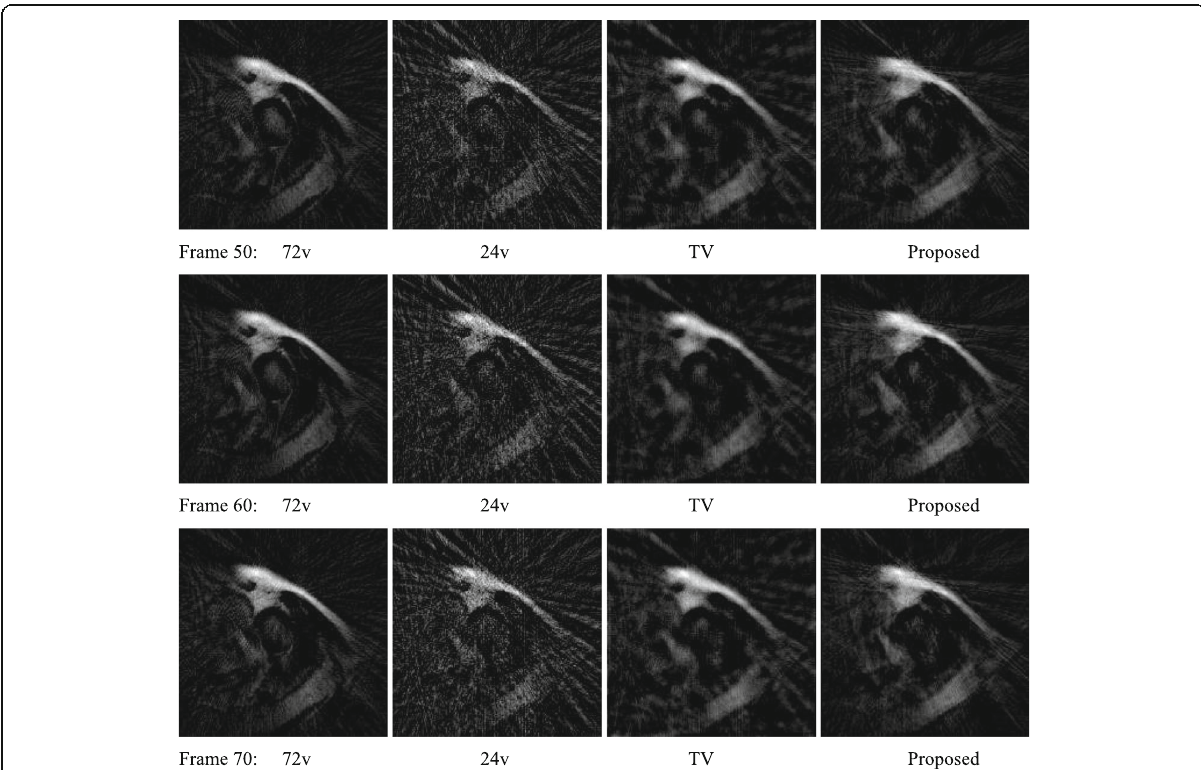
Fig. 5 (Frame 50 ~ 70). MRI patient image reconstructions by using (1st column) 72-view FBP, (2nd column) 24-view FBP, (3rd column) 24-view iterative TV, and (4th column) 24-view proposed method. The 1st column is treated as the gold standard for other columns to compare with. The three rows of images correspond to time frames of 50, 60 and 70, respectively